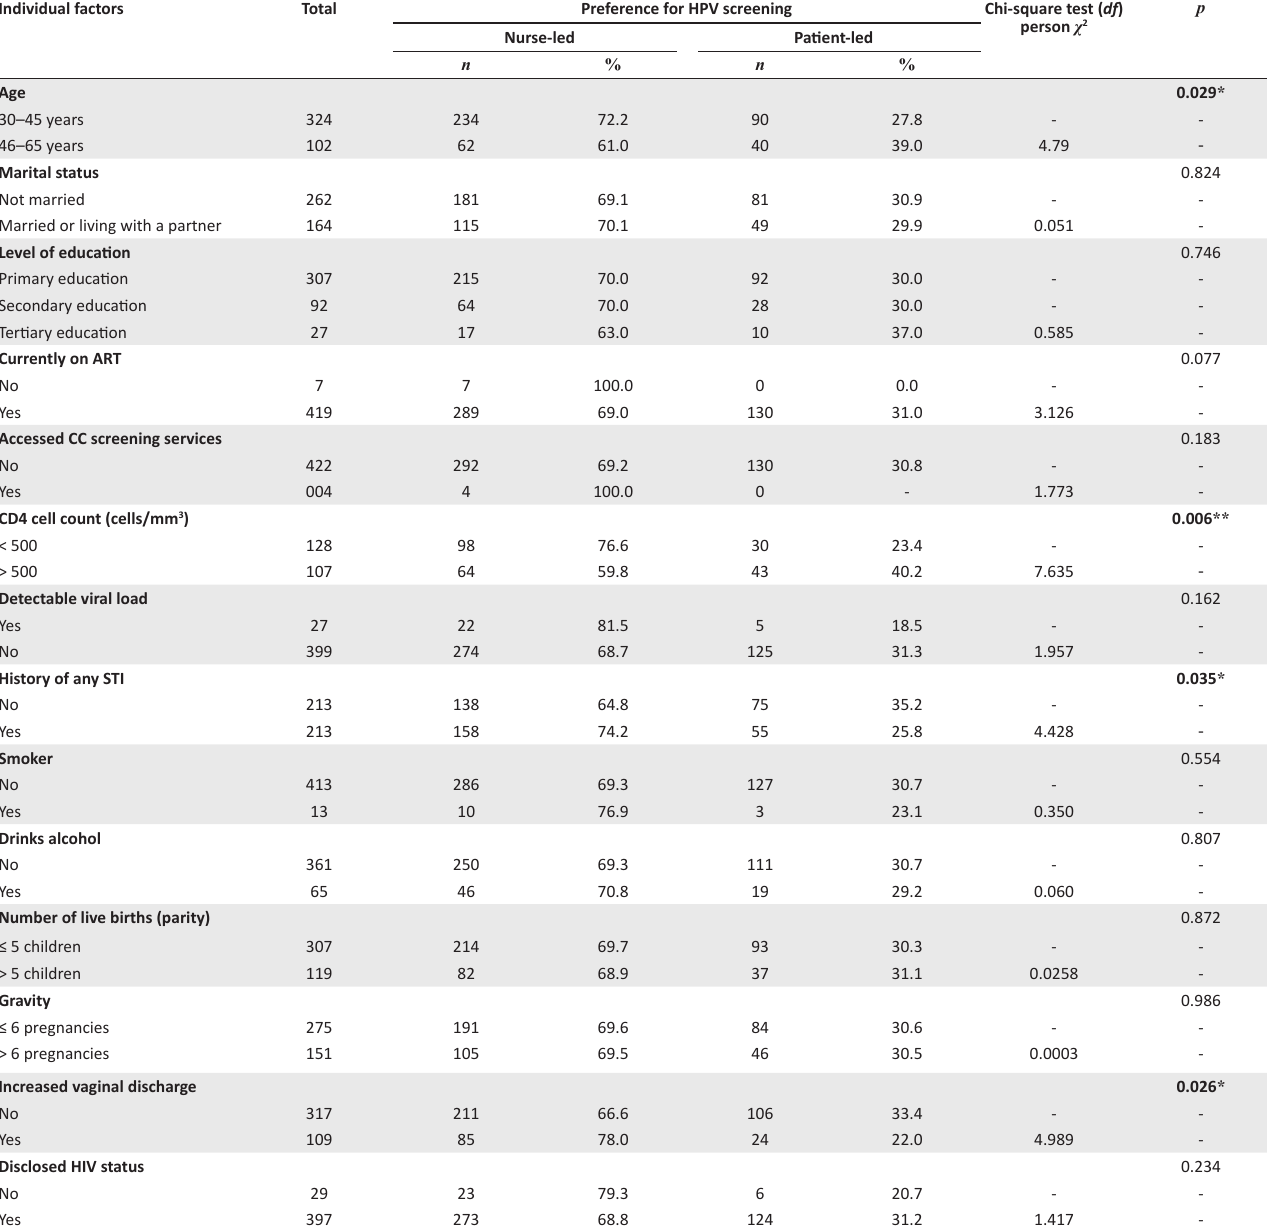
TABLE 1: Individual factors associated with preference for human papilloma virus sample collection procedure. Individual